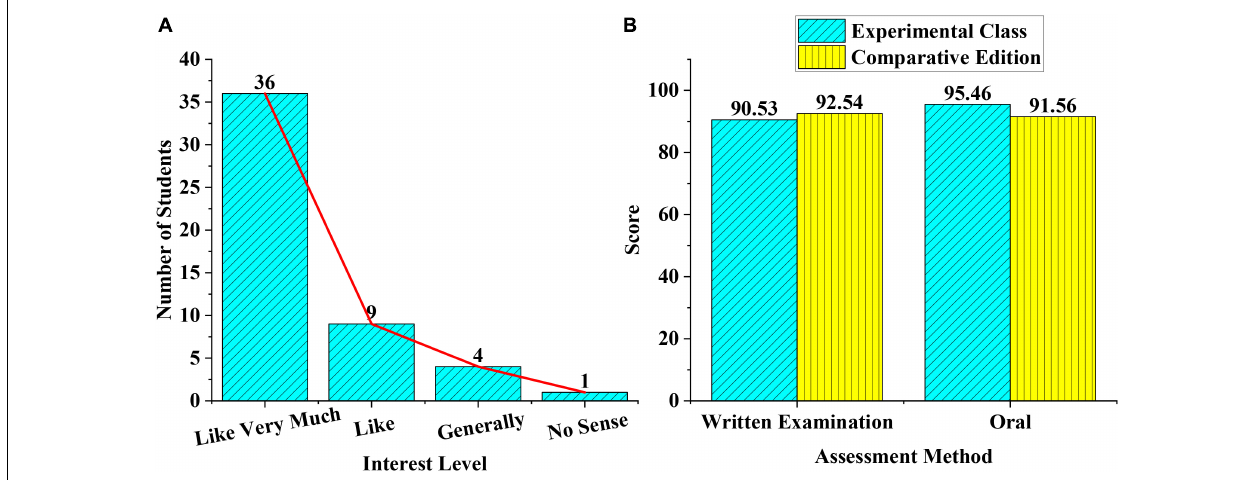
FIGURE 8 | Result statistics (A) the class’s interest in the automatic creation ballad system, (B) the average scores of written and oral tests between the experimental class and the control class in the mid-term